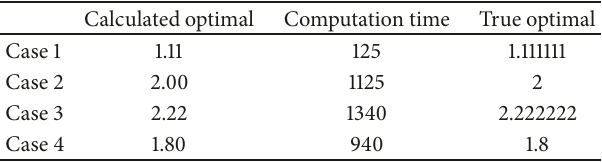
Table14:Comparisonbetweencalculatedoptimalsolutionandtrue optimal